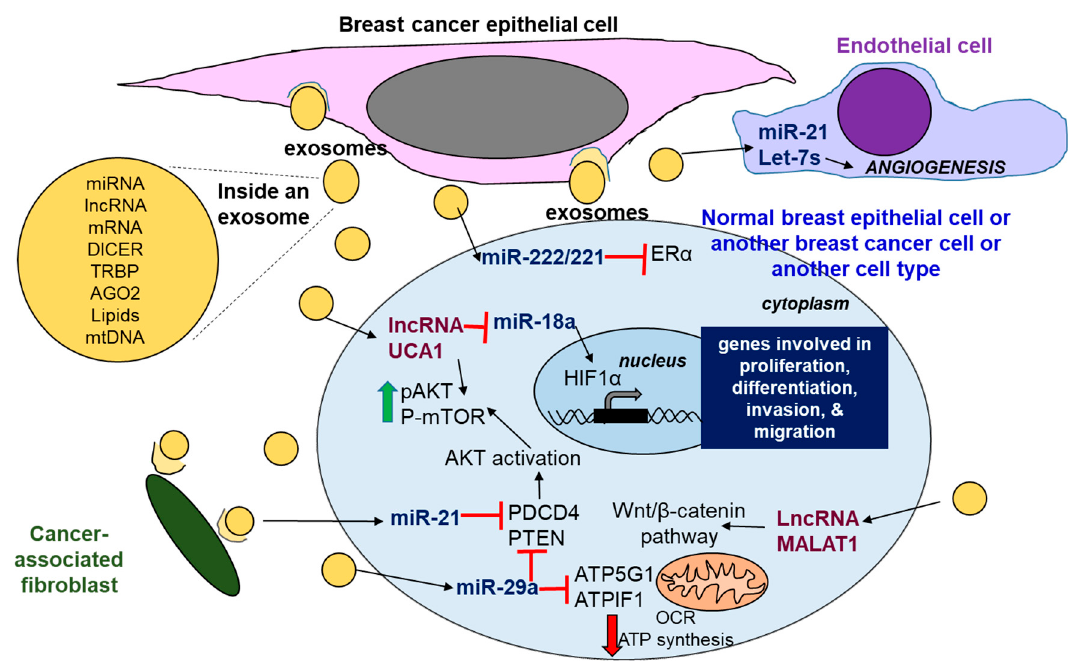
Figure 4. Exosomal transfer of miRNAs and lncRNAs in breast cancer. Exosomes released from breast cancer cells and cancer-associated fibroblasts into the extracellular compartment contain ncRNAs, mRNAs, mtDNA, proteins, and lipids. Exosomes can deliver their contents to adjacent cells or cells at a distance. Examples of miRNAs and lncRNAs in breast cancer exosomes and their known roles in breast cancer are shown.